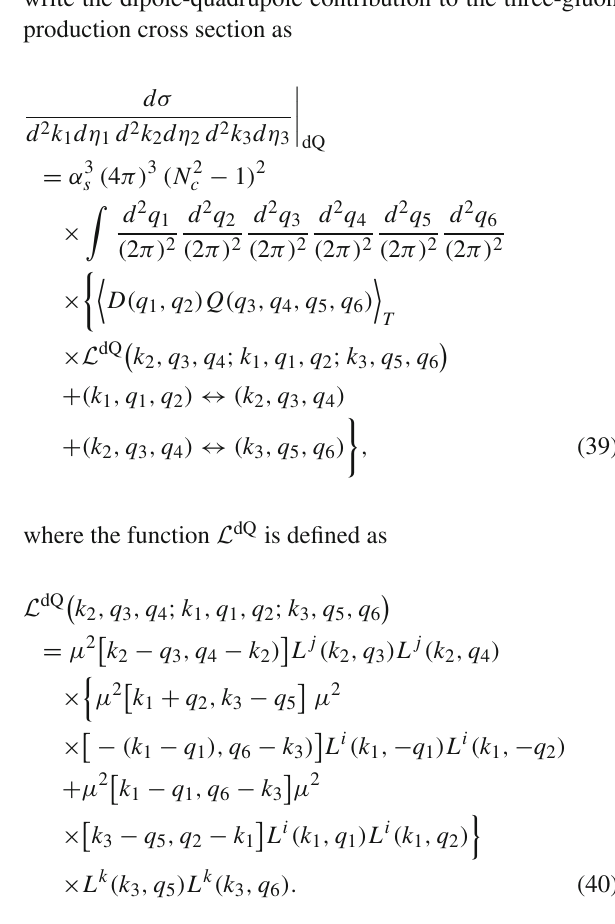
Fig. 8 Graphical illustration of the term that is proportional to